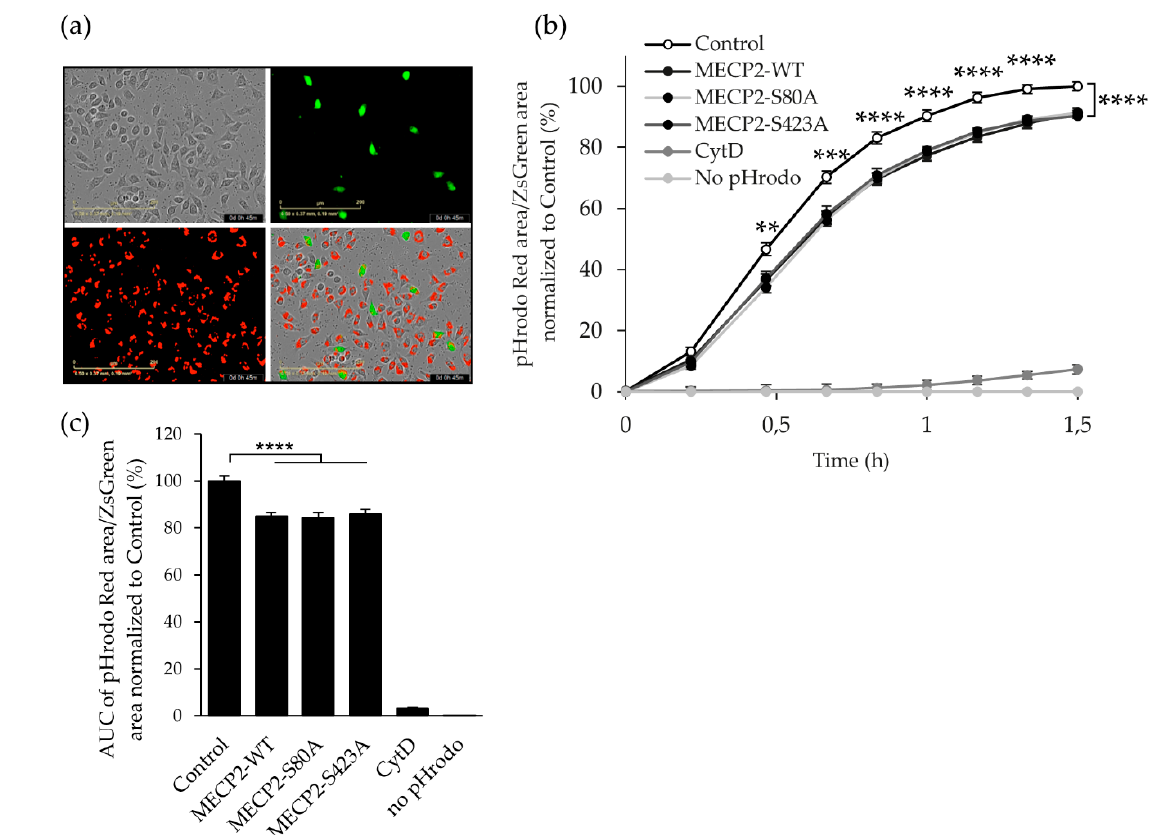
Figure 4. Overexpression of MECP2 decreases zymosan particle phagocytosis in BV2 cells independently of MECP2 phosphorylation at serine 80 or serine 423. BV2 cells were transduced with lentivirus vectors encoding MECP2-WT-Myc, MECP2-S80A-Myc, MECP-S423A-Myc, or plasmid backbone only (Control) seven days prior to phagocytosis assay. The vector backbone contained the elongation factor-1 alpha (EF1 α ) promoter and green fluorescent protein (ZsGreen1) coding sequence separated by an internal ribosome entry site (IRES). Cells were incubated with pHrodo-labeled zymosan particles (5 ng/µL) and fluorescence emission was measured using the IncuCyte S3 imaging platform every 0.2 h for 1.5 h at 37 °C. ( a ) Representative images showing phase-contrast (BV2 cells), green fluorescence (ZsGreen1) and red fluorescence (pHrodo) signal and overlay 0.75 h after addition of pHrodo-labeled zymosan particles. ( b ) Red pHrodo signal was quantified in ZsGreen-positive areas. To control the assay, 2.5 µM cytochalasin D (CytD) was used as an inhibitor of phagocytosis. Data are shown as Mean ± SEM of n ≥ 8 of two independent experiments. One-way ANOVA, post-hoc LSD from each timepoint, ** p < 0.01, *** p < 0.001, **** p < 0.0001. ( c ) Overall phagocytosis measure area under the curve (AUC). Data are shown as Mean + SEM of n ≥ 8 of two independent experiments. One-way ANOVA, post-hoc LSD, **** p < 0.0001.